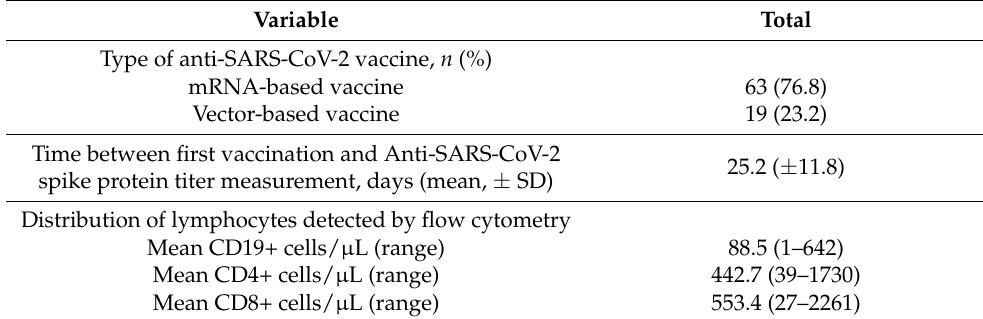
Table 2. Patient characteristics regarding distribution of lymphocytes and anti-SARS-CoV-2 vaccination. Variable